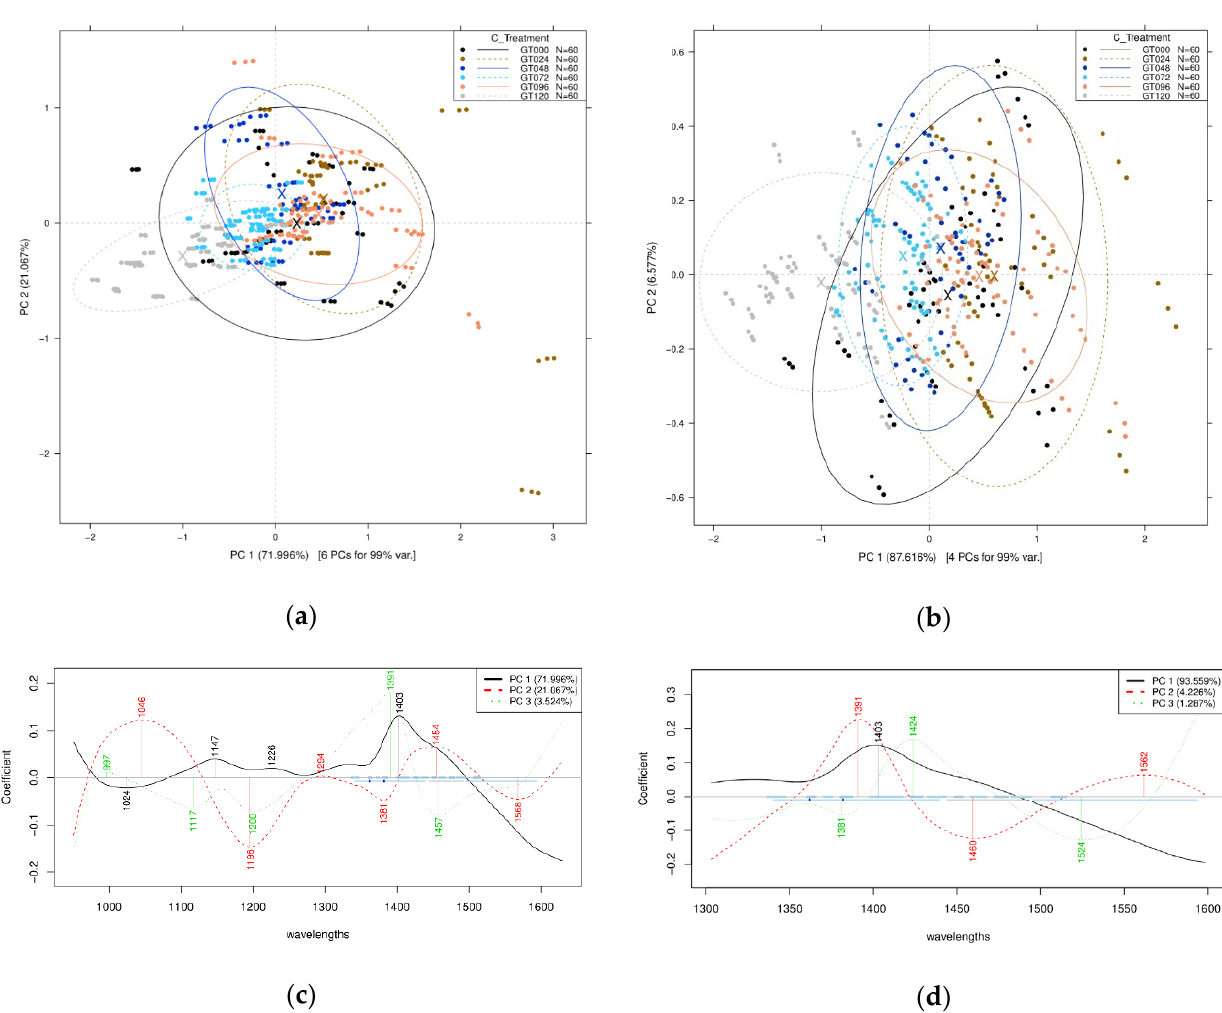
Figure 2. Principal component analysis (PCA) of germination time on the entire Near-Infrared Spectroscopy (NIRS) spectral data of the mung bean sprout after Savitzky-Golay smoothing (SG) and standard normal variate (SNV) pretreatment of the spectra: ( a ) Score plot within 950–1630 nm wavelength interval, ( b ) score plot within 1300–1600 nm first O-H overtone wavelength, ( c ) principal components (PC) loadings plot within 950–1630 nm wavelength interval, and ( d ) PC loadings plot within 1300–1600 nm wavelength interval.